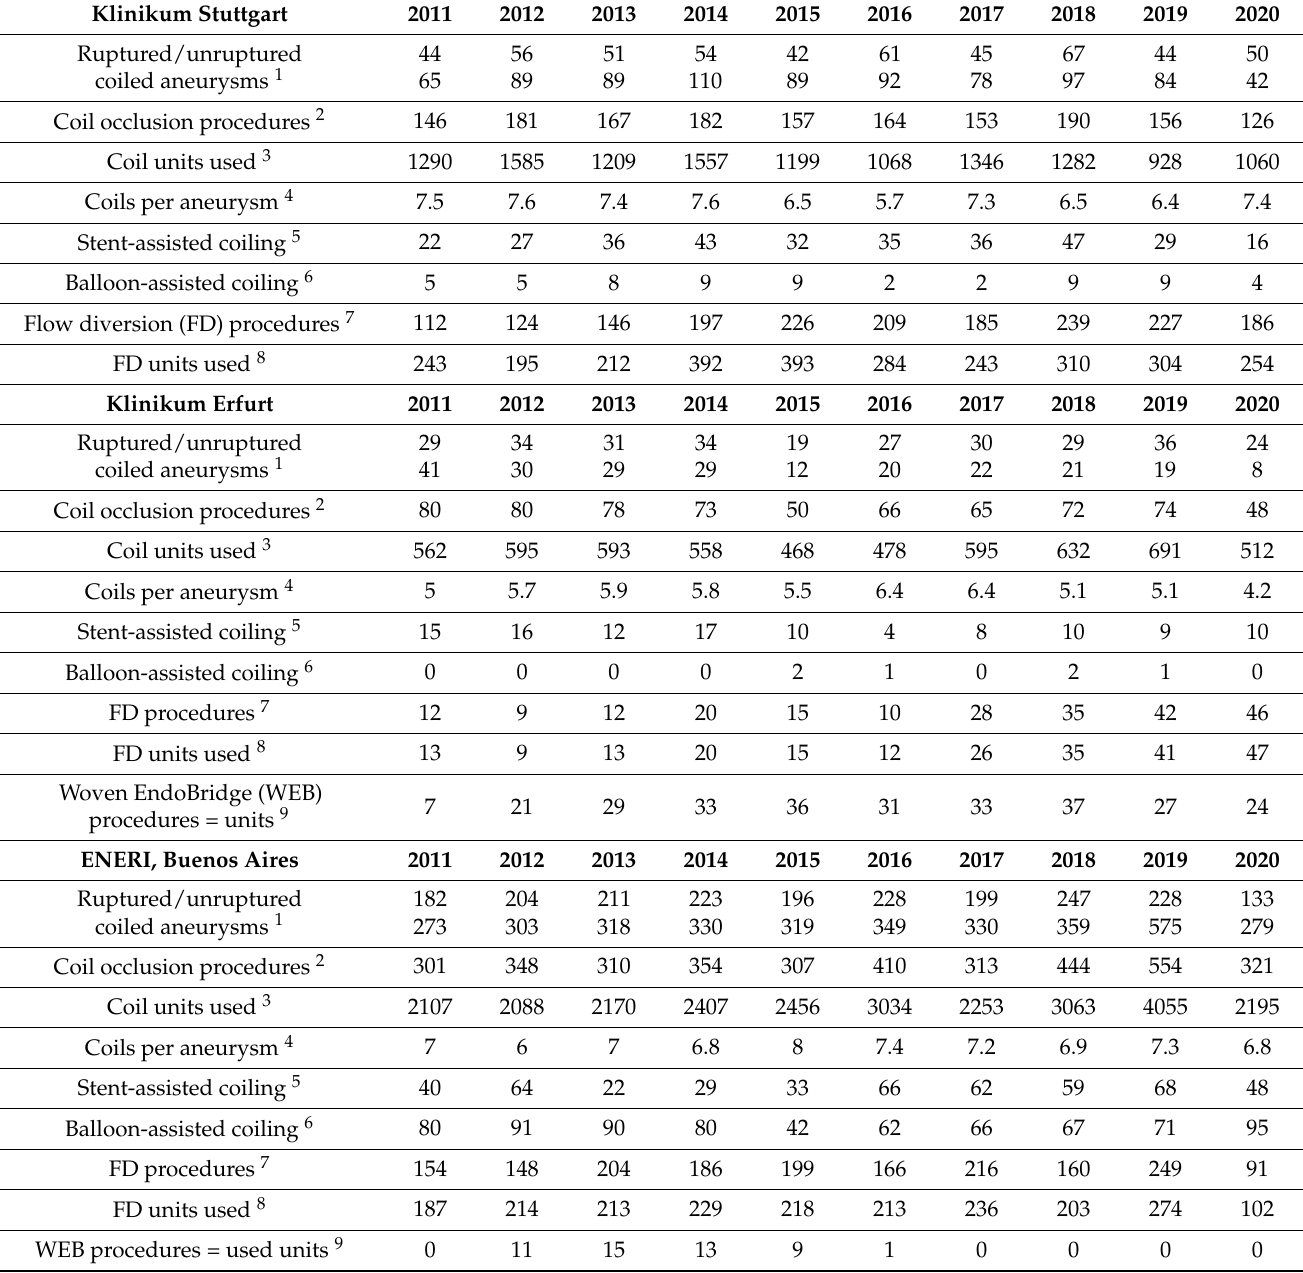
Table 1. Number of aneurysms treated with coil occlusion, flow diversion, or WEB implanta- tion and the annual use of coil and flow diverter (FD) units during the years 2011–2020 in three hospital-based specialized neuroendovascular departments, Klinikum Stuttgart (Stuttgart, Germany), Helios Klinikum Erfurt (Erfurt, Germany), and Clinical La Sagrada Familia, ENERI (Buenos Aires, Argentina); 1 values for coiled aneurysms only; 2 coil occlusion procedures performed to treat aneurysms and for all other indications; 3 annual consumption of detachable coils for any indication; 4 the mean number of coils used per aneurysm; 5 the number of aneurysm treatments that included the use of a self-expanding stent deployed to support coil occlusion; 6 the number of aneurysm treatments that included the use of a remodelling balloon catheter to support the coil occlusion; 7 the number of aneurysm treatments that included the deployment of a flow diverter stent; 8 the annual consumption of flow diverter stents; 9 the number of WEB devices implanted (typically one per